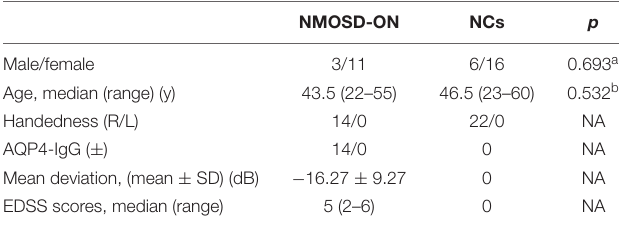
TABLE 1 | Demographic and clinical characteristics of NMOSD-ON and NCs